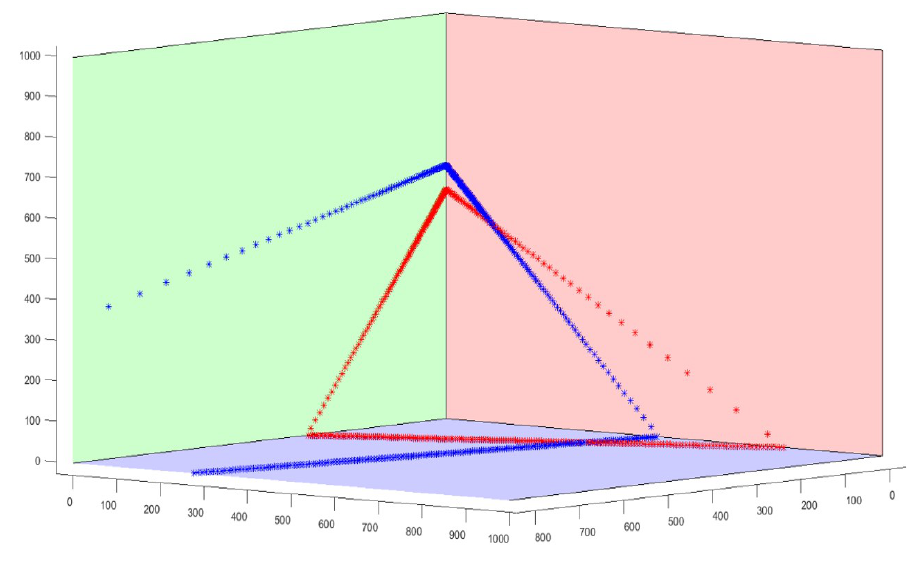
Figure 5. Schematic diagram of emulational laser